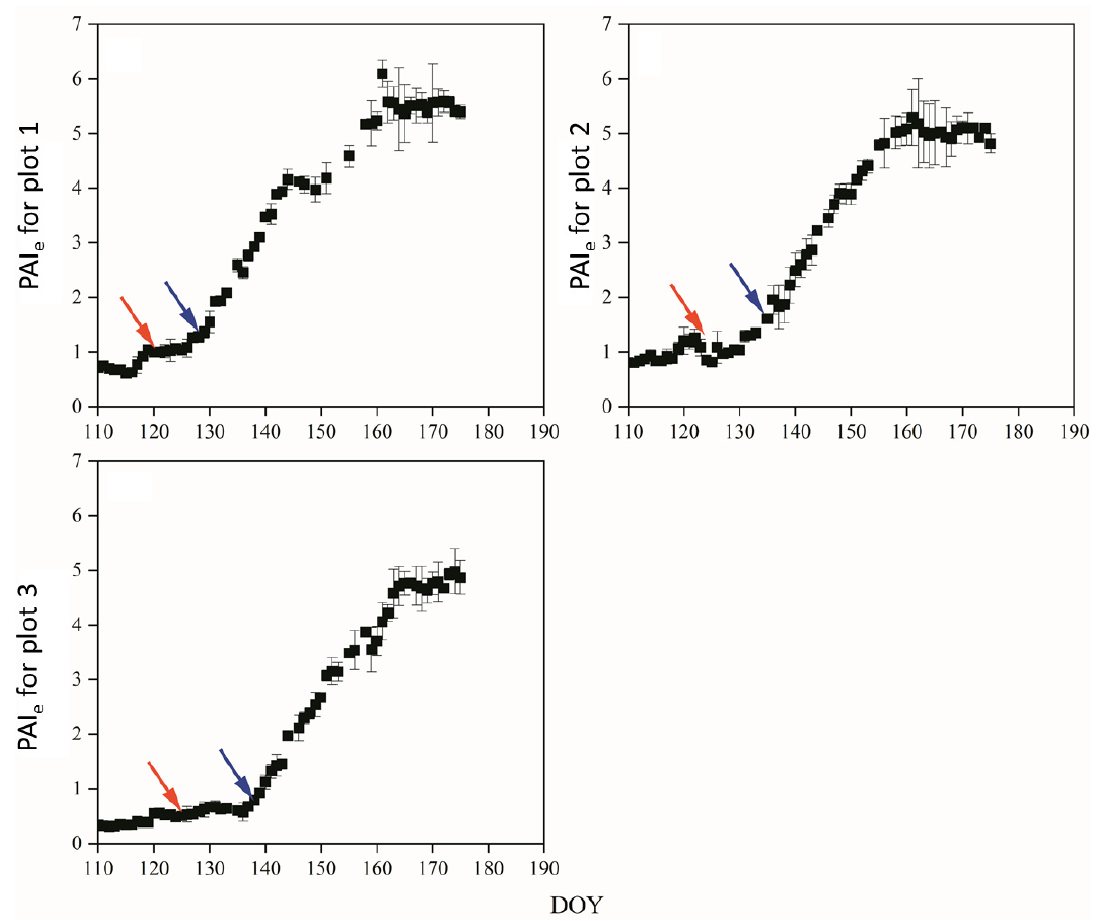
Figure 7. Time series of PAI e from the AHS in three plots of Maoershan Experimental Forest Farm. The red arrows show the shrubs spread their leaves, the blue arrows show the second increase.